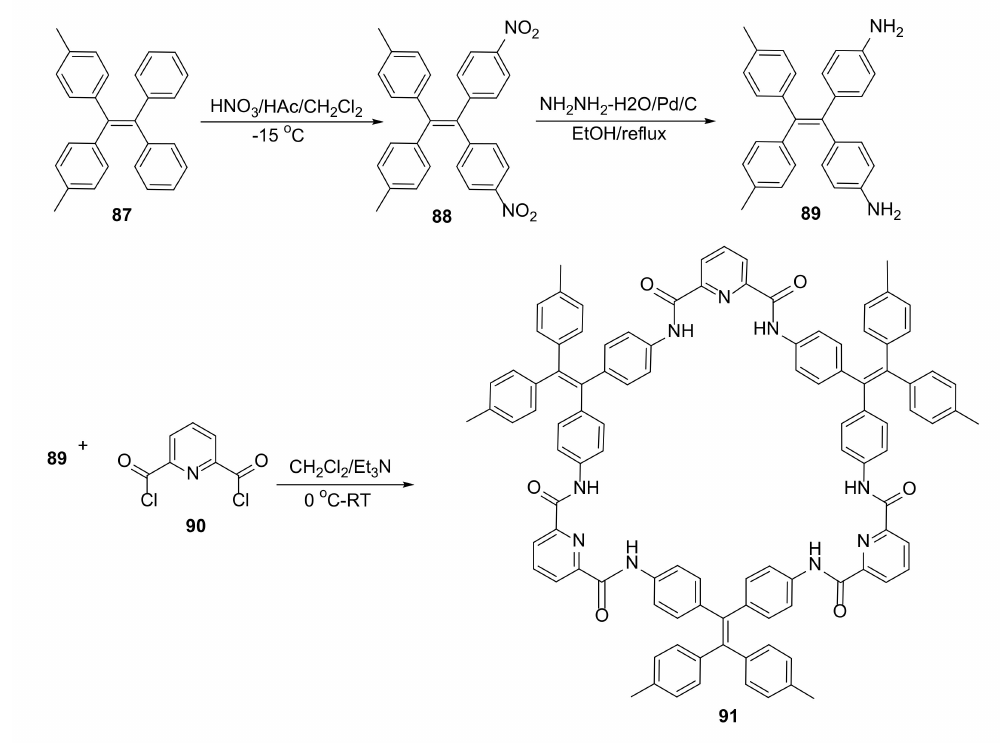
Figure 17. Synthesis of macrocycle 91, which can selectively absorb TNT